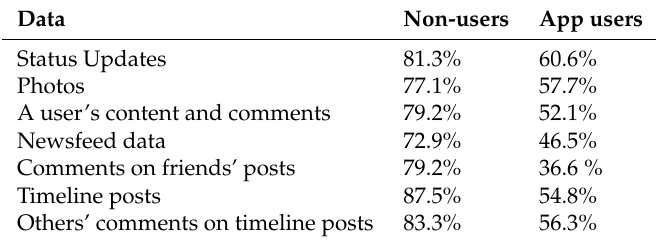
Facebook apps can access certain types of data. Differences are significant in all cases for p < 0.05. We see that app users are significantly less likely to believe that apps have access to this